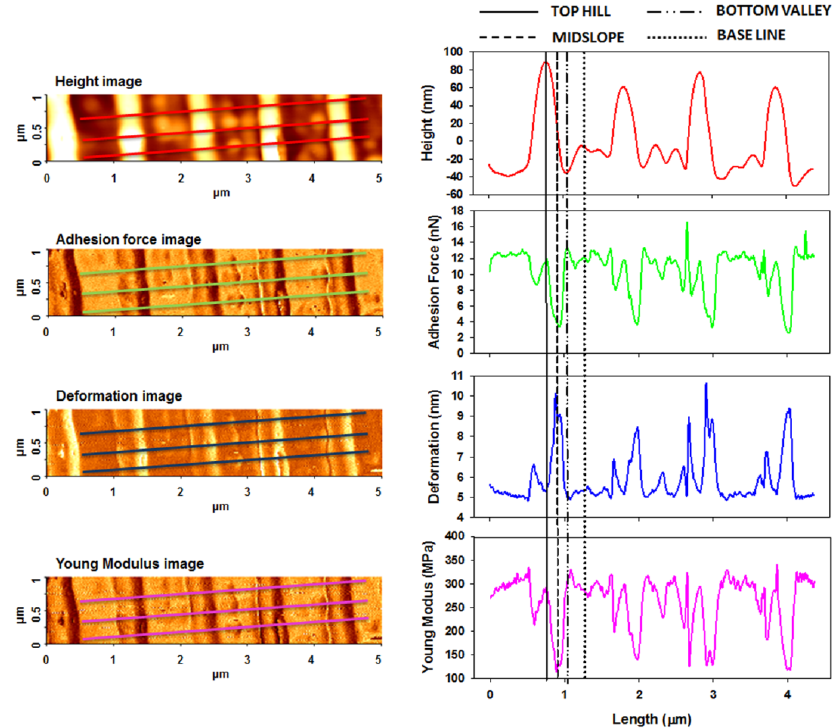
Figure 8. AFM PinPoint combined height, adhesion force, deformation, and Young’s modulus images and corresponding cross-section profiles mediated from the presented three lines obtained for azo-polyimide irradiated with a laser energy density of 45 mJ/cm 2 and 100 pulses. Table 2. The values of the nanomechanical characteristics (adhesion force, deformation, and Young’s modulus) measured at different positions on the azo-polyimide samples before and after laser irradiation by using AFM PinPoint mode. Sample